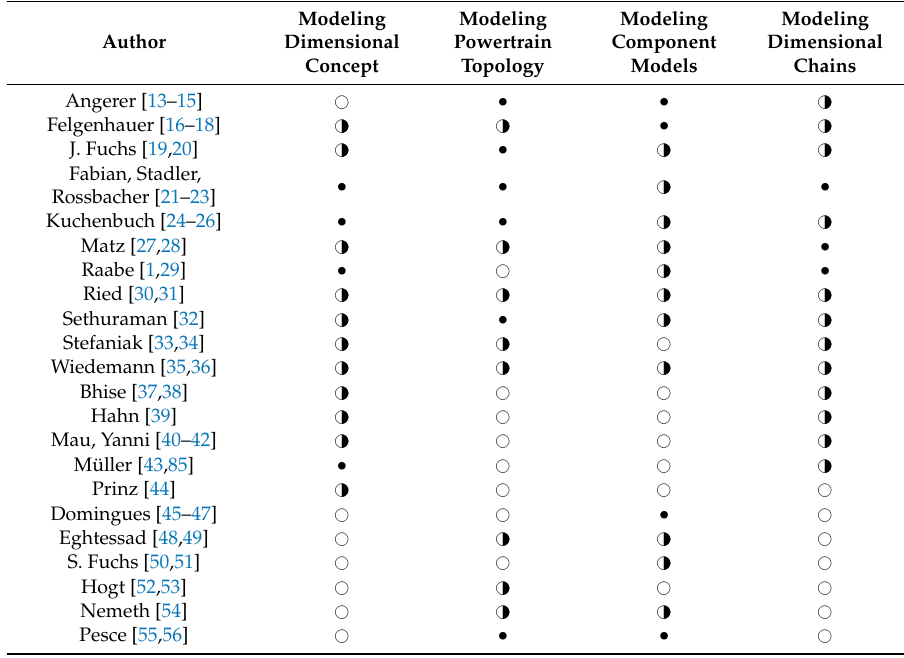
Table A1. Overview of the relevant